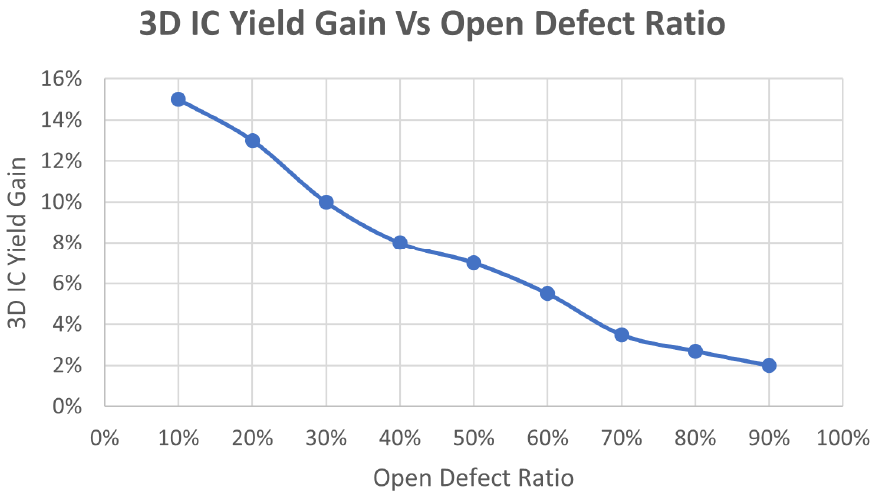
Figure 15. Three-dimensional IC yield gain vs. open defect ratio.